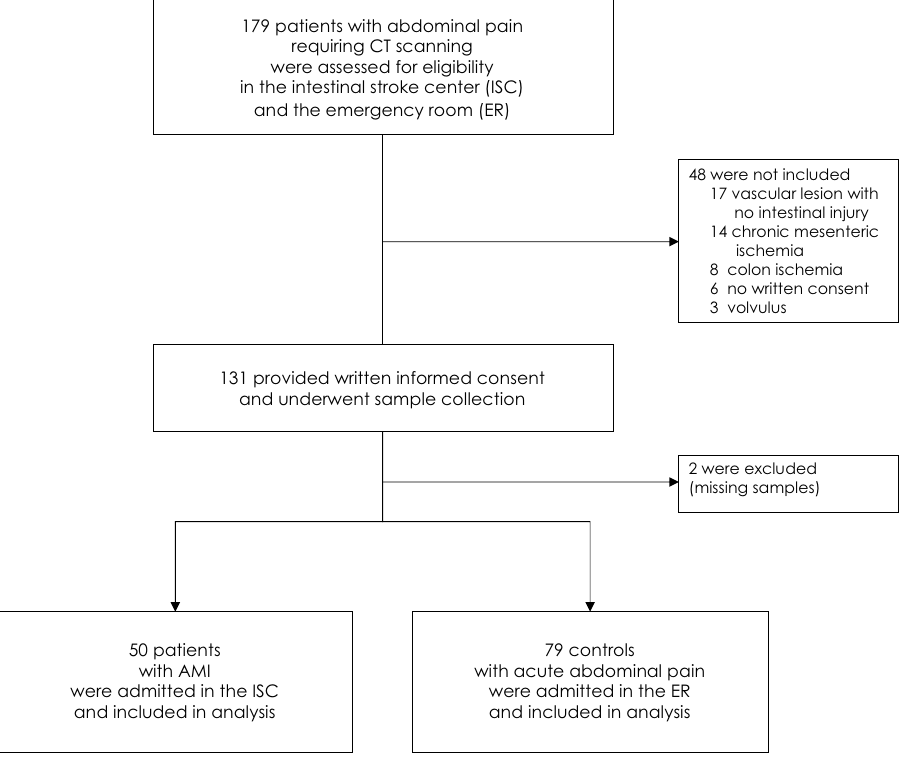
Figure 1. Flowchart of AMI patients and controls: screening and selection. Abbreviations: AMI acute mesenteric ischemia, CT contrast-enhanced computed